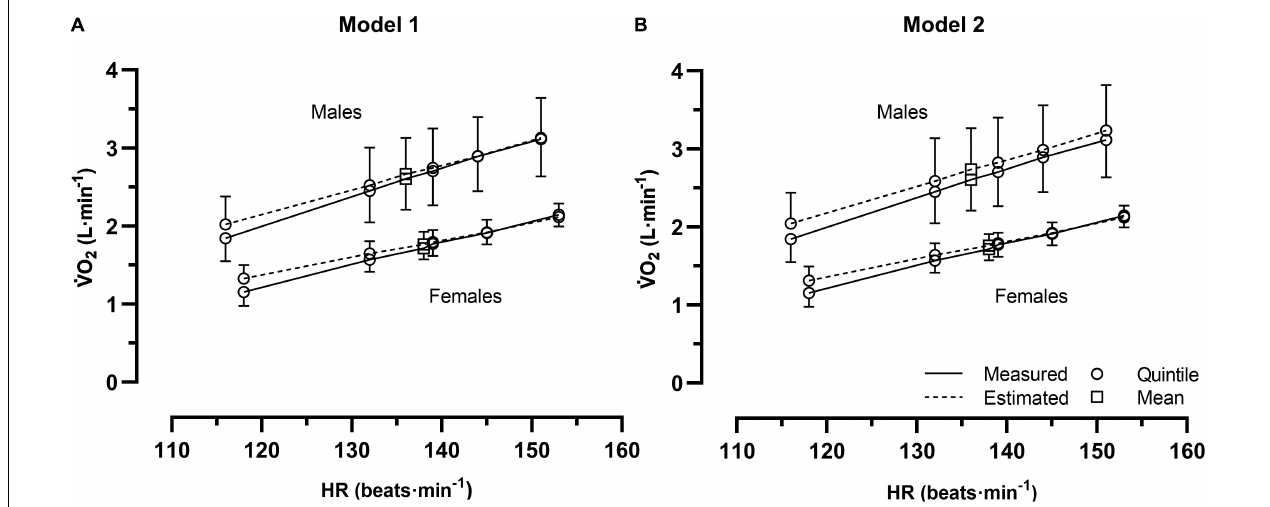
FIGURE 2 | The measured and estimated oxygen uptake (˙VO 2 ) with model 1 (A) and model 2 (B) between six positions of heart rate (HR) for males ( n = 10) and females ( n = 10), separately, during cycle commuting (mean plus the upper half, or minus the lower half of the 95%